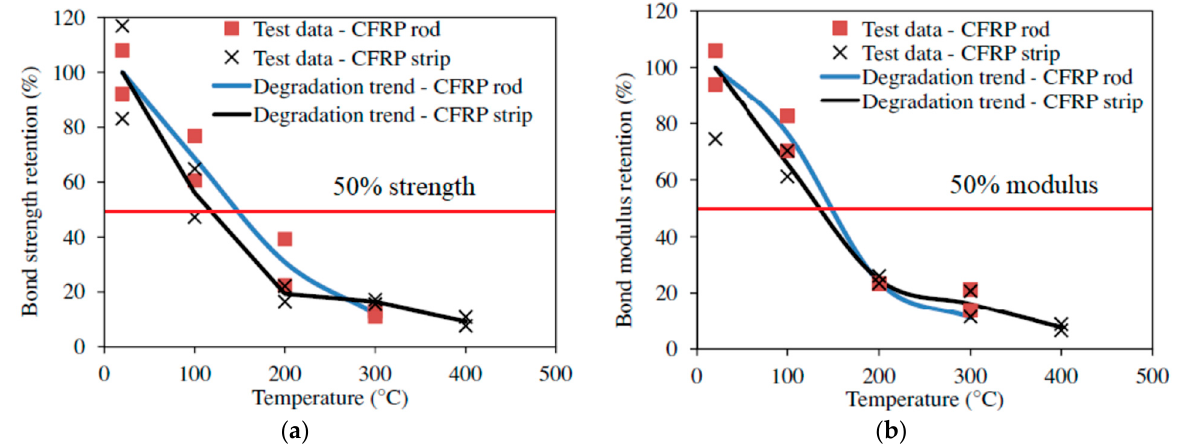
Figure 14. Variation of bond strength and elastic modulus of NSM CFRP strips and rods with Tyfo T300 epoxy with temperature; ( a ) Bond strength; ( b ) Bond modulus.